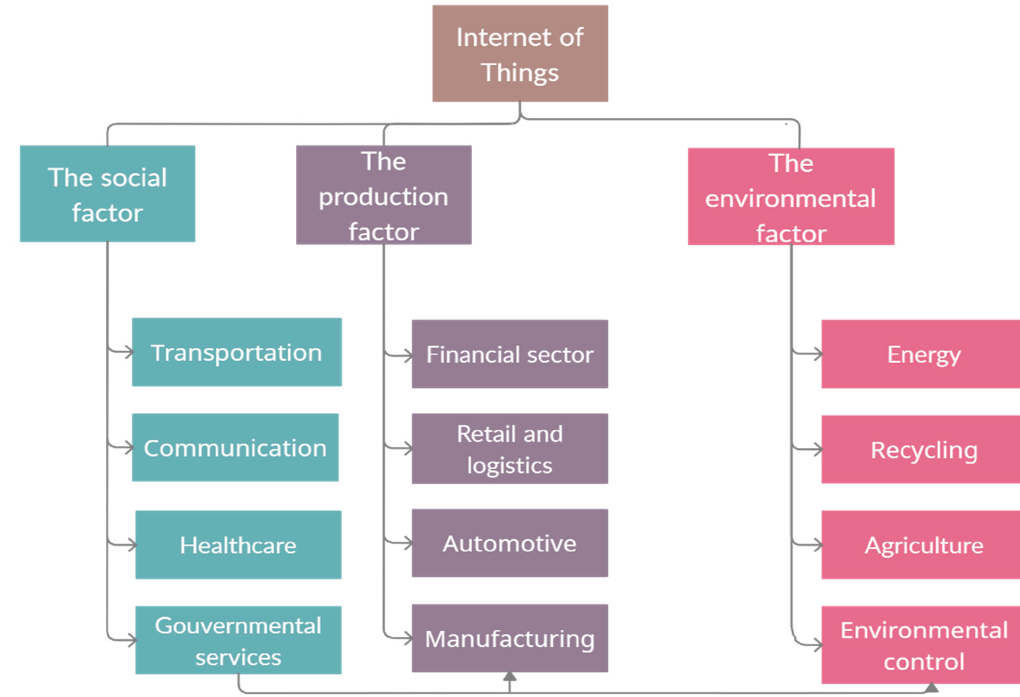
Figure 1. The main areas of IoT applicability.